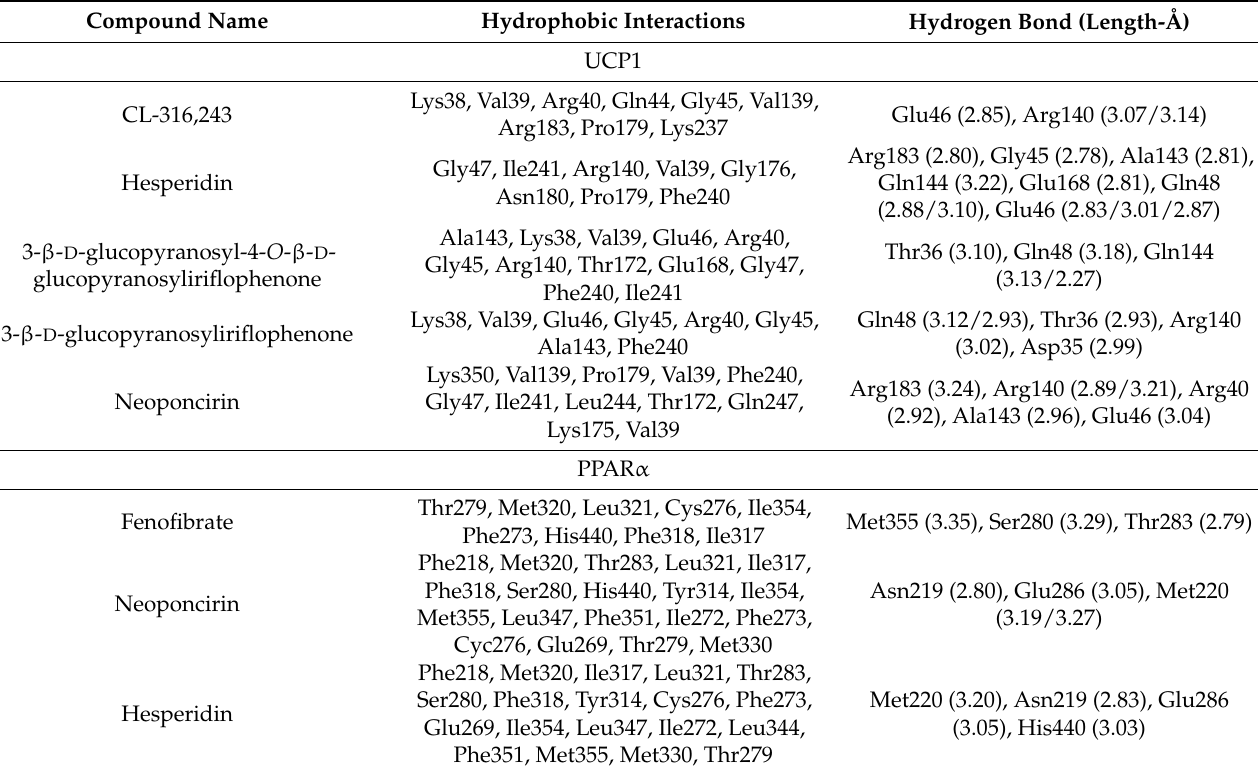
Table 1. Molecular docking scores and ligand interaction plot analysis of CPEF compounds bound to UCP1 and PPAR α